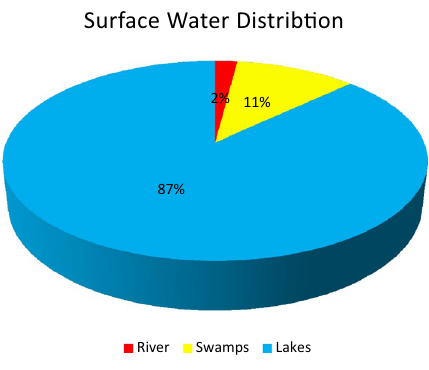
Fig. 3 Percentage of surface freshwater